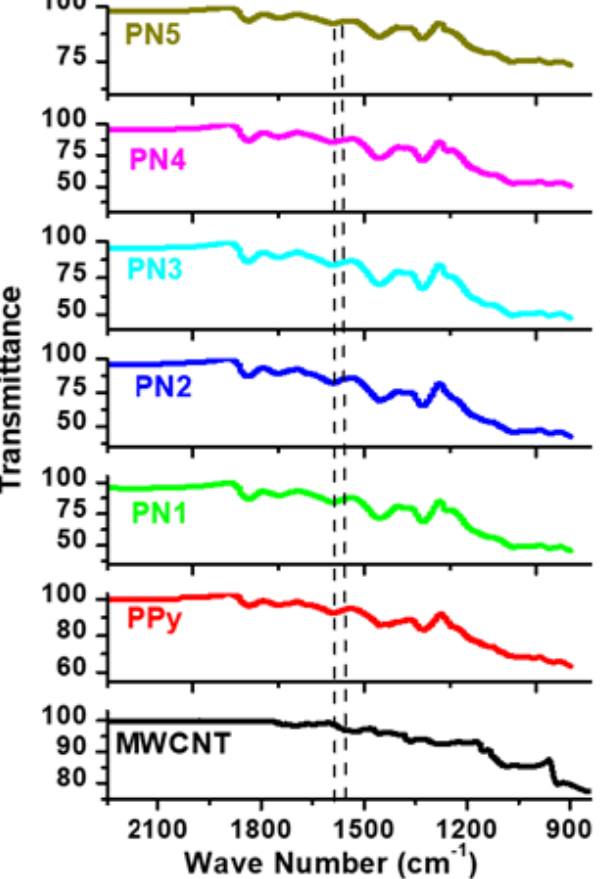
Figure 6. FTIR spectra of the MWCNTs/PPy nanocomposites. Spectra of the pure MWCNTs and PPy are also shown.